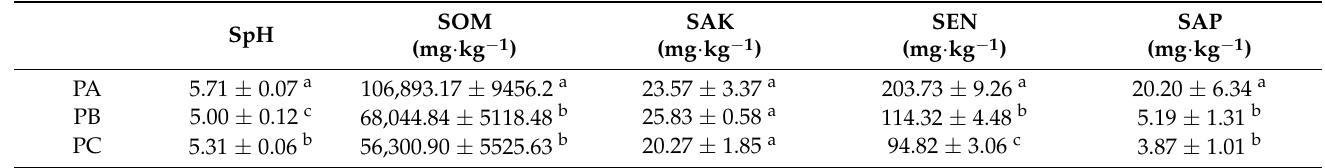
Table 1. One ‐ way analysis of variance of abiotic factors in the soil. Table 1. One-way analysis of variance of abiotic factors in the soil. SOM SpH